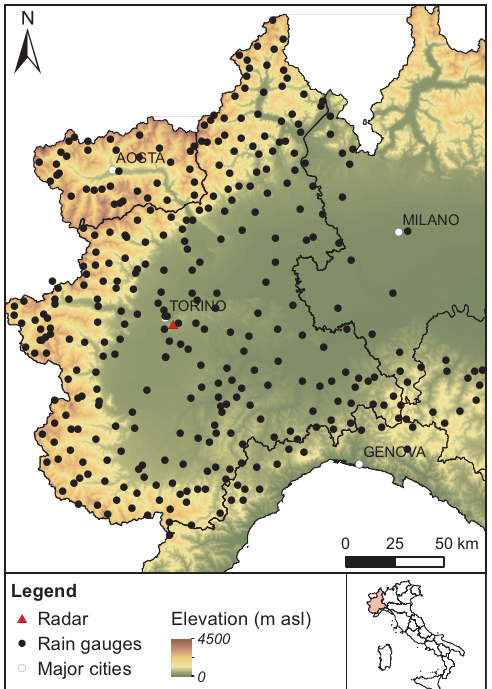
Figure 2. Orography of the study area and locations of “Bric della Croce” radar and rain gauge